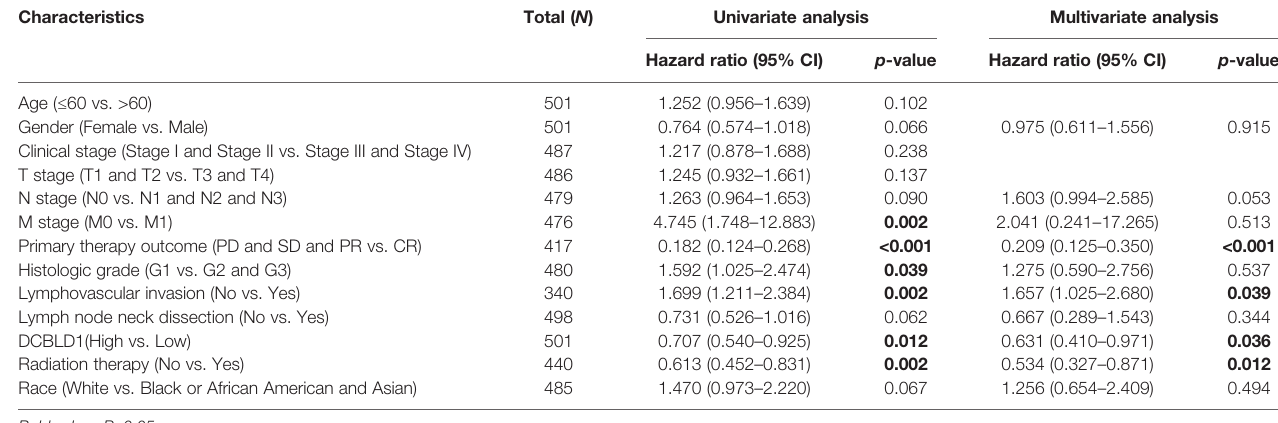
TABLE 2 | Association of clinicopathological characteristics with overall survival using univariate or multivariate Cox regression analysis. Characteristics